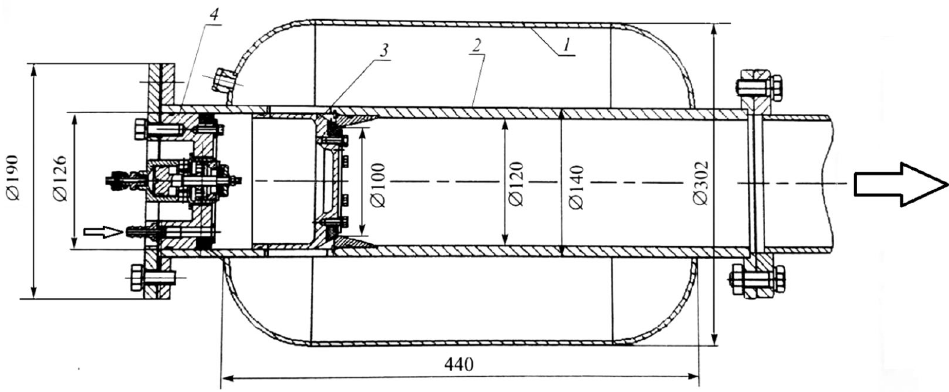
Figure 4. Assembly drawing of the air impulse generator AIG-25/8.